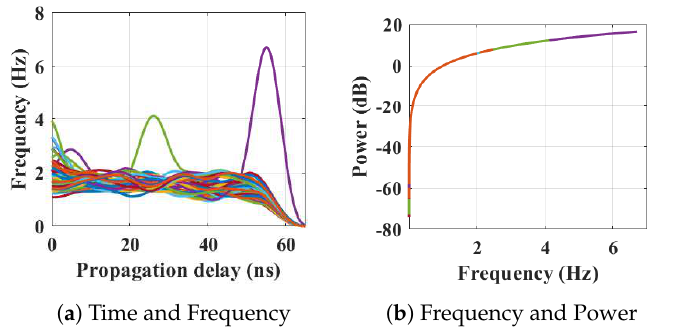
Figure 8. The relationship between propagation delay, activity frequency, and received power from the radar responses obtained while the person is washing a bowl in the kitchen has been considered as C5 in classification